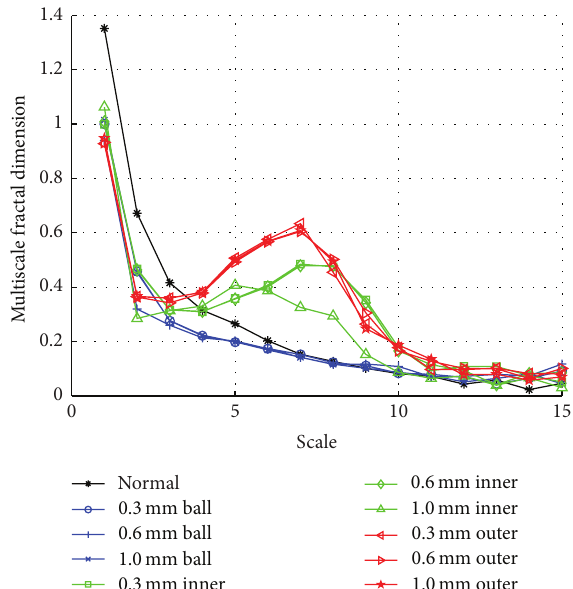
Figure 3: Multiscale general fractal dimensions of different bear- ings.